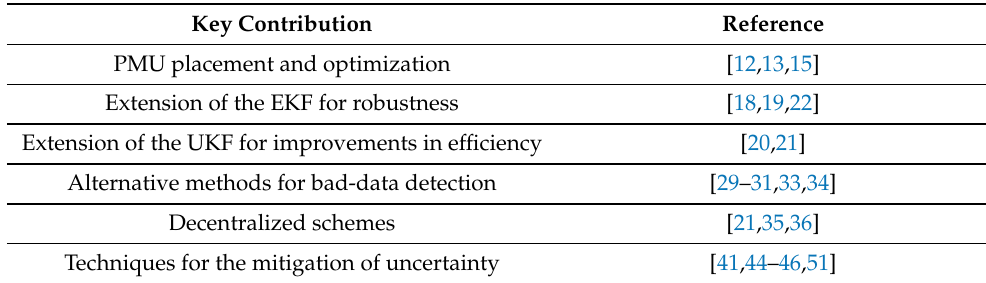
Table 1. Summary of